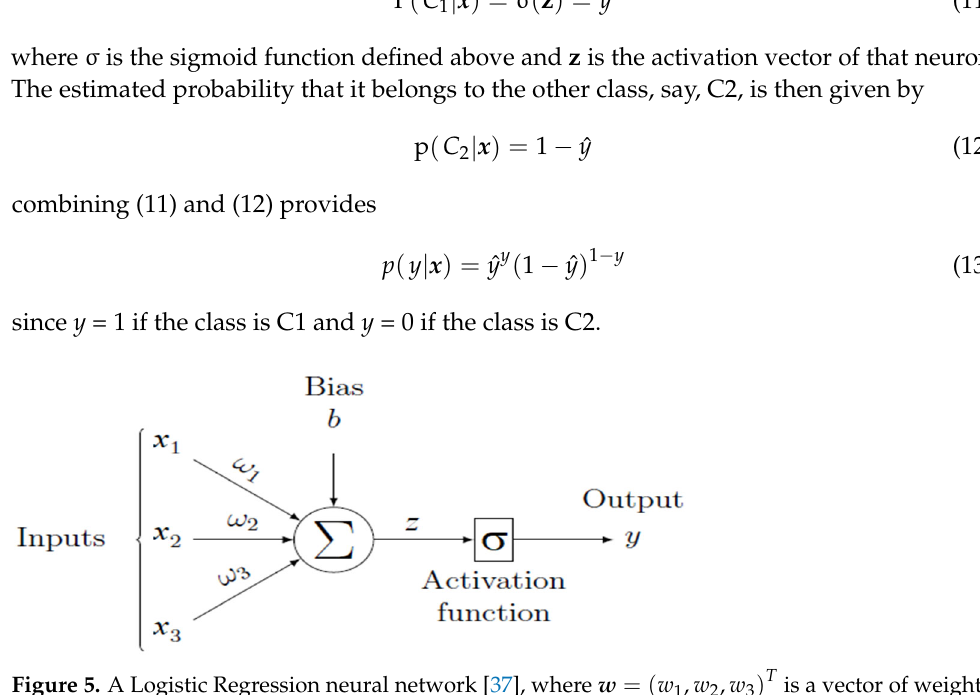
w i x i + b is its i